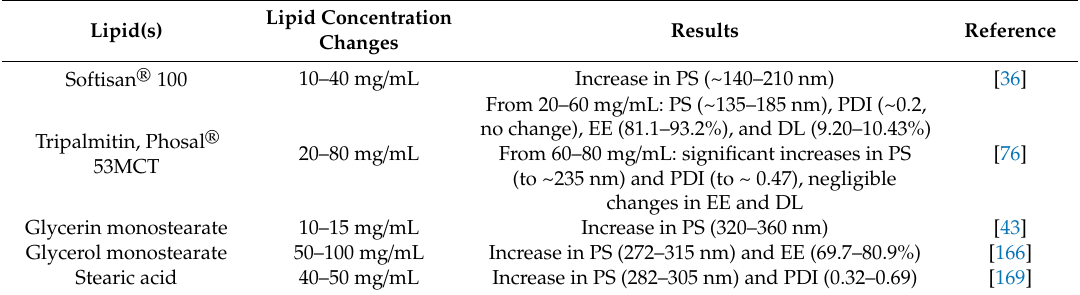
Table 3. E ff ects of total lipid concentration on properties of SLNs and